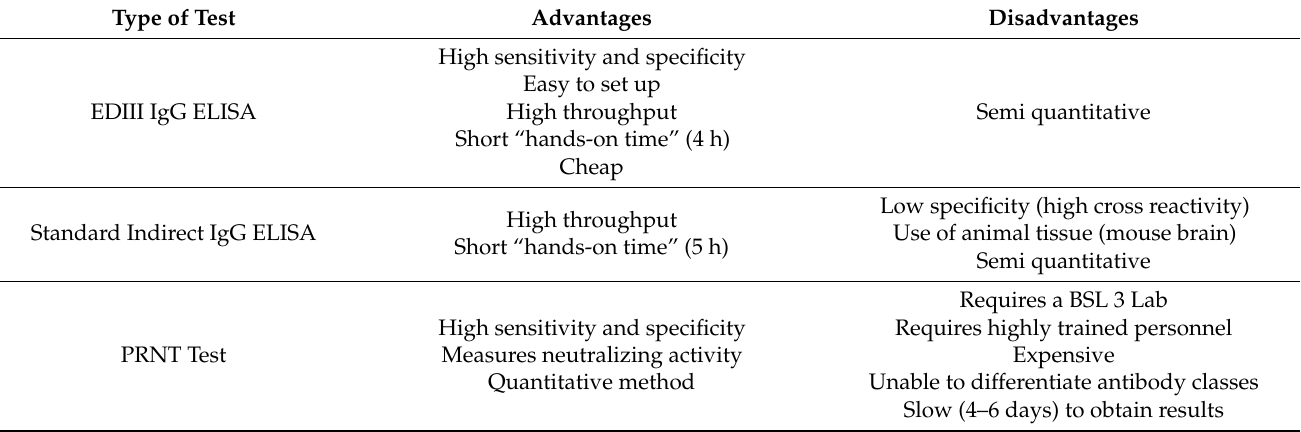
Table 6. Advantages and drawbacks of EDIII ELISA in comparison to standard IgG ELISA and